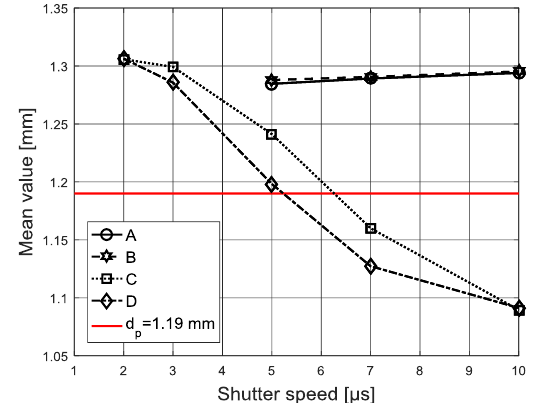
Fig. 10. Normal distribution – mean particle value – effect of shutter speed (red line = calibration particle